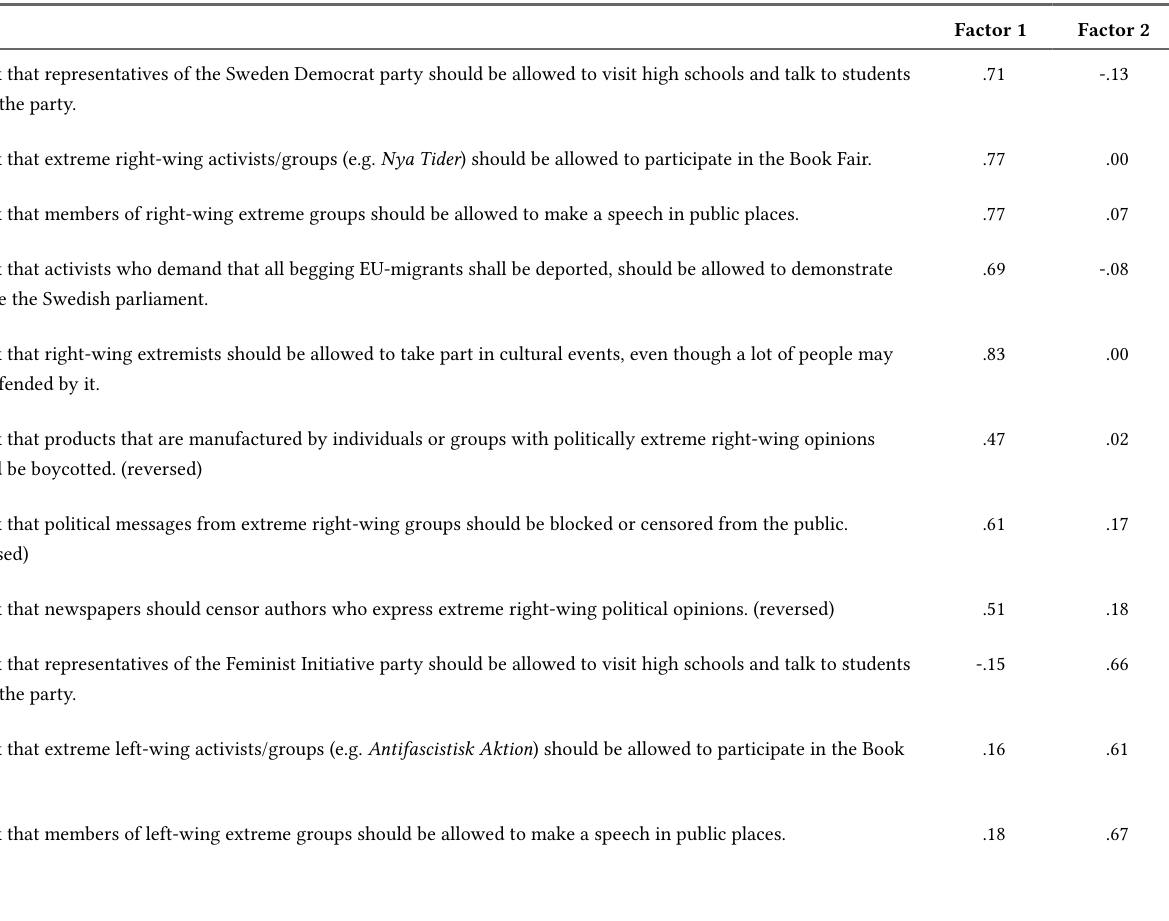
Exploratory Factor Analysis for the Items That Measured Tolerance of Right-Wing and Left-Wing Extremists in Experiment 2